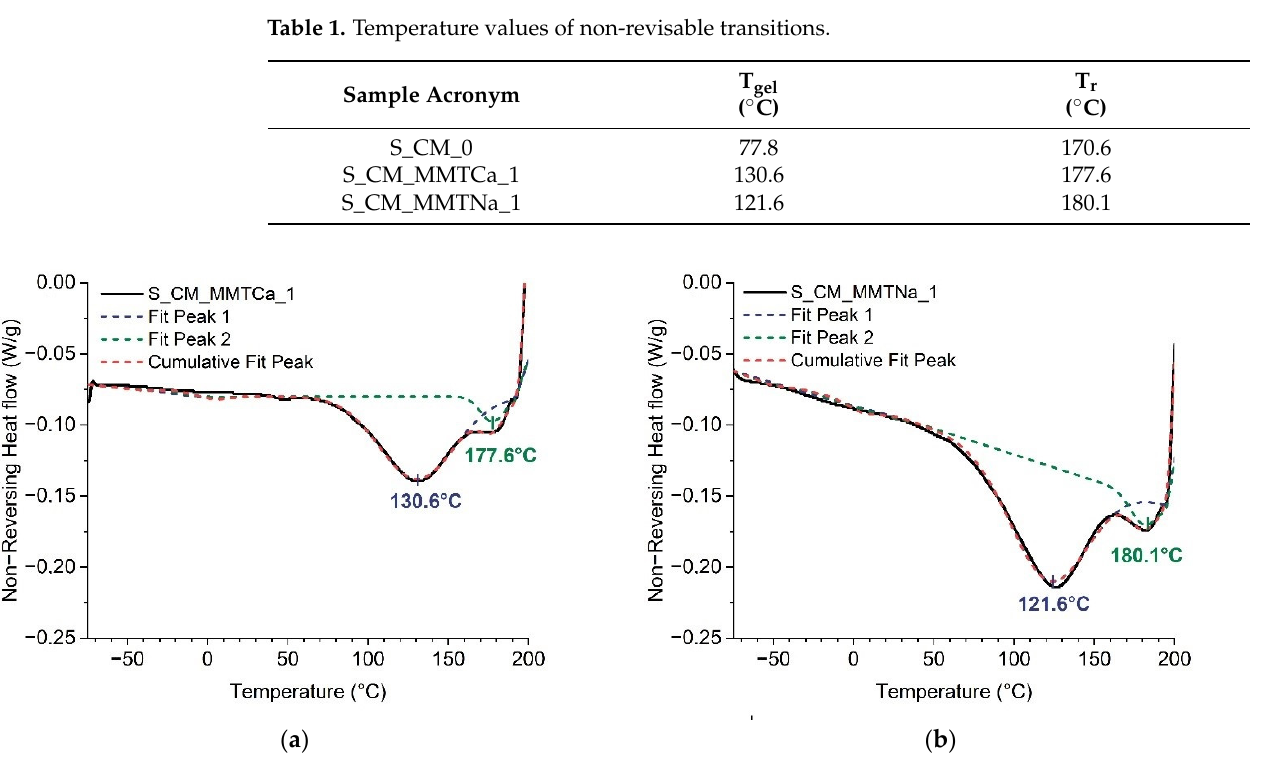
Table 1. Temperature values of non-revisable transitions.